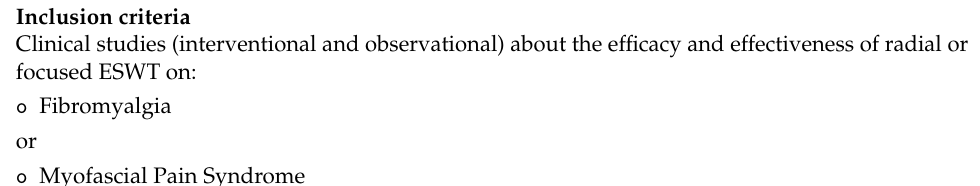
Table 2. Eligibility criteria.